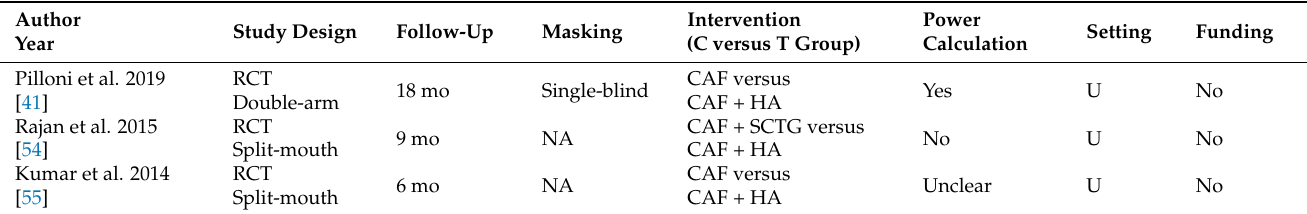
Table 1. Characteristics of included studies.